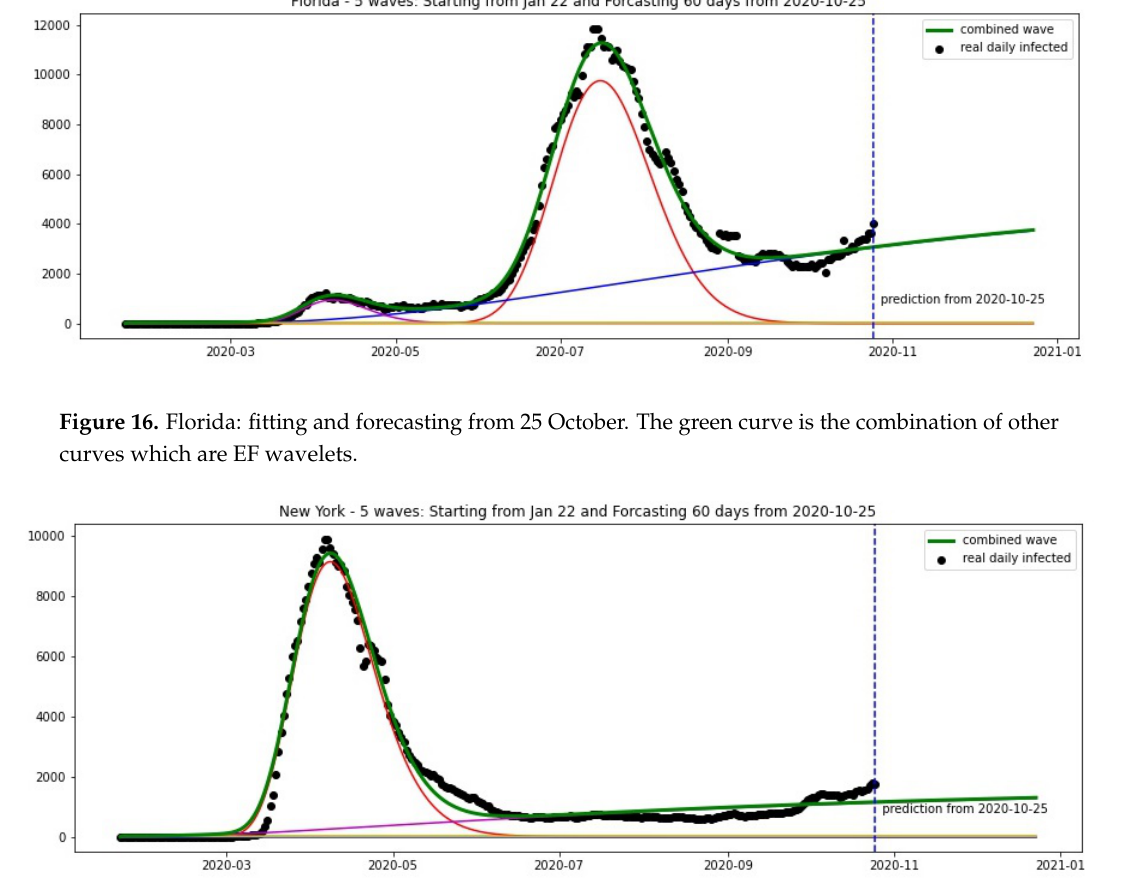
Figure 17. New York: fitting and forecasting from 25 October. The green curve is the combination of other curves which are EF